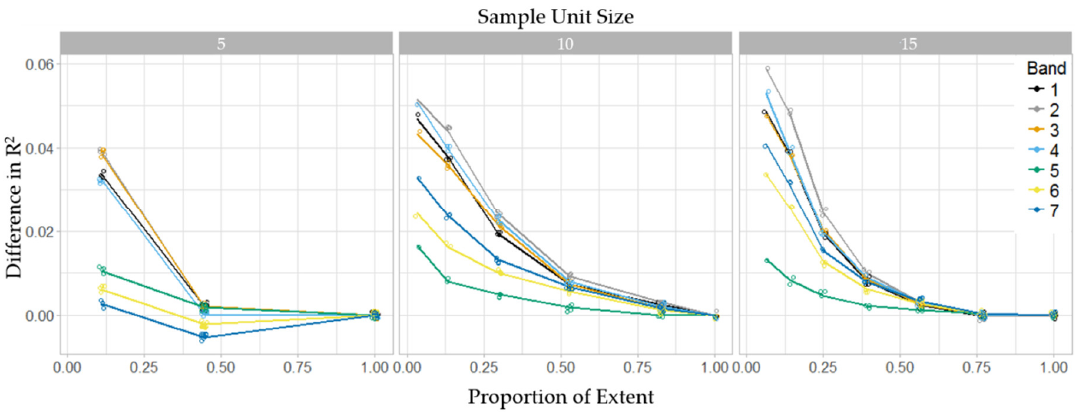
Figure A3. Reduction in the proportion of variation explained ( R 2 ) for Landsat 8 image by subsample intensity (Proportion of Extent), sample unit size, and spectral band using SYS 4 and P all subsampling layout.